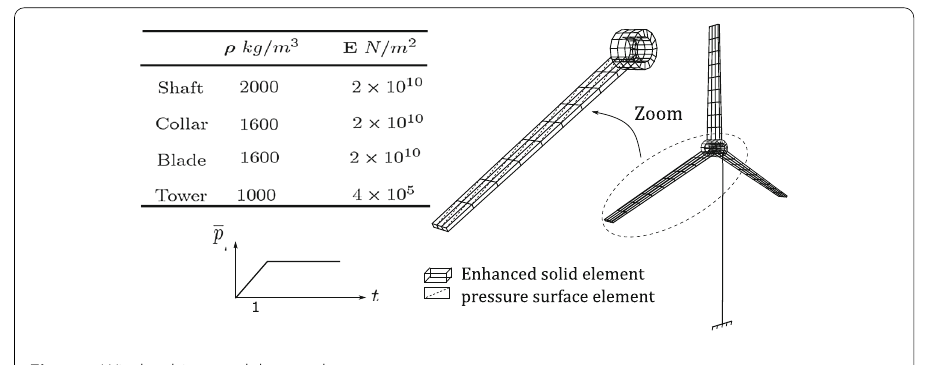
Fig. 11 Wind turbine model